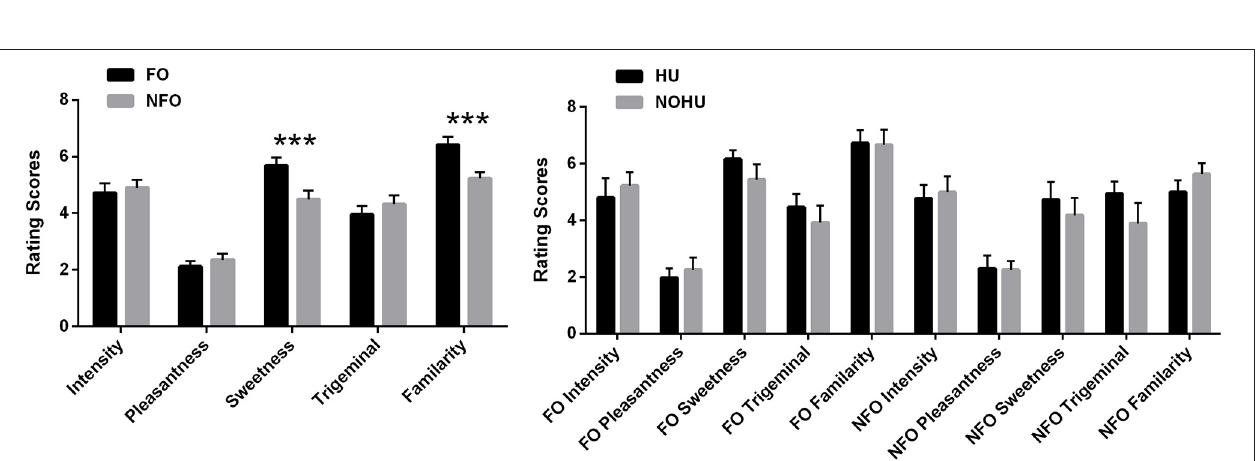
Frontiers in Human Neuroscience |